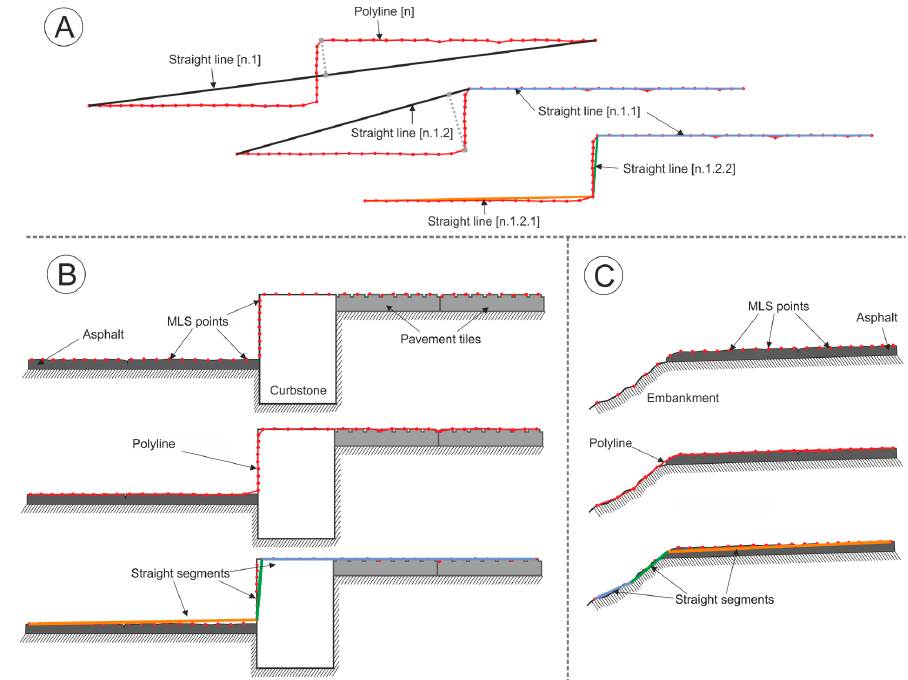
Figure 2. ( A ) transformation of a polyline into a set of straight lines. ( B ) and ( C ) Point cloud simplification on two different road edge profiles; ( B ) road edge on an embankment; ( C ) road edge in an urban environment (with curb/pavement).